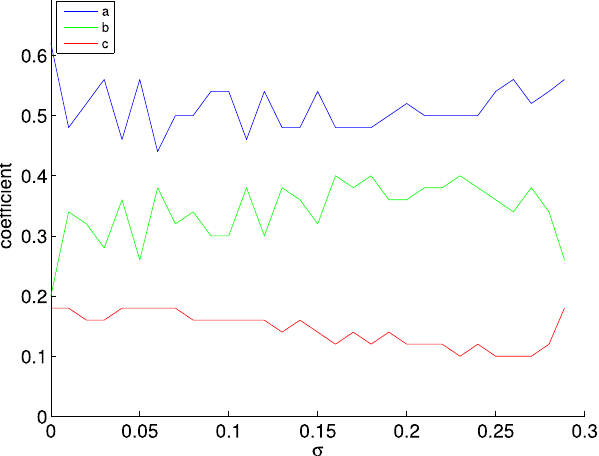
Figure 6. Impact of standard deviation σ on the optimal weights of BI (from Eq. (1), with a + b + c = 1) for desired cascade S goal = 0.5, for ER graphs with N = 10,000, 〈 k 〉 = 10, ρ = 0, with φ = . 0 5 , averaged for 500 different network realizations each with a different threshold generation. The resolution in the a and b weight space are 0.02.